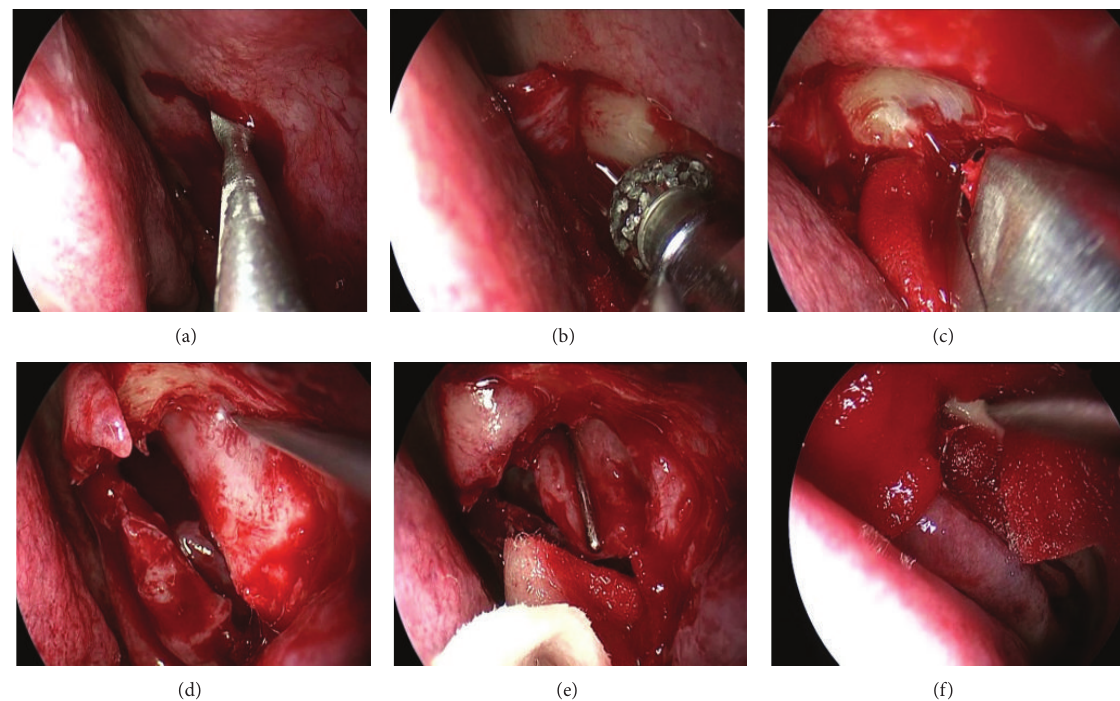
Figure 1: EE-DCR. A square nasal mucosal flap was incised by a blade (a) and a power blur then was used to thin maxilla and frontal process of the maxilla (b), a rongeur to remove the bone (c), and a probe to bulge medial sac and allow the medial wall of the sac fully incised (d); finally the entire sac was opened (e) and the wound was packed with merogel